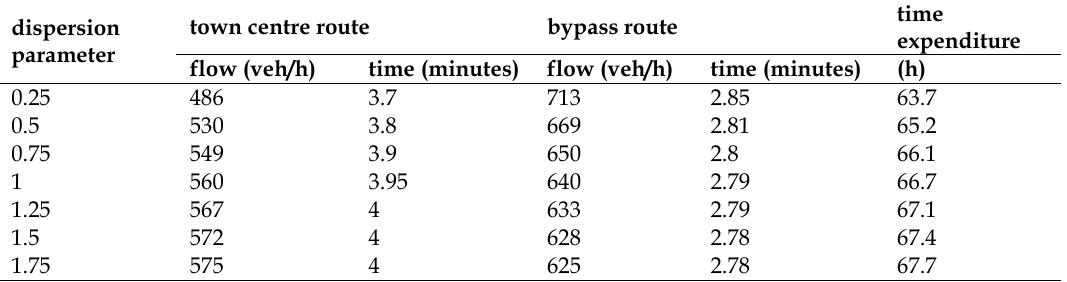
Table 5. RDSUE results with no toll: sensitivity to dispersion